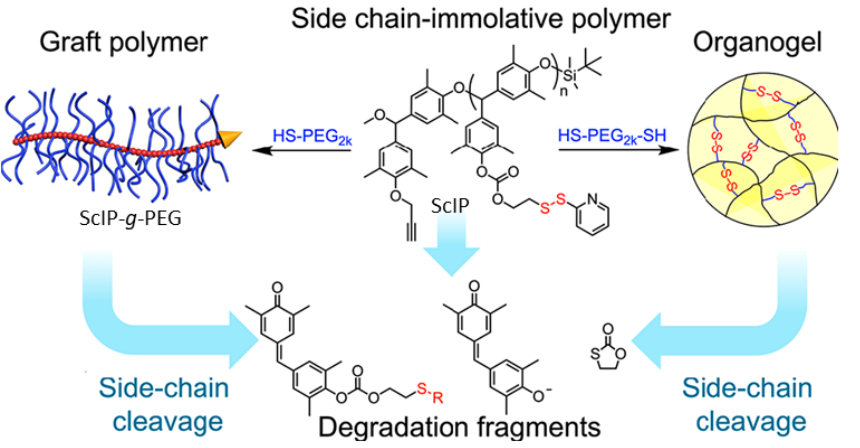
Figure 24. PBE-based ScIP structure, and reactions with mono- and bis-mercapto-terminated PEG. The graft polymer (ScIP-g-PEG), organogel, and ScIP can all be degraded by DTT. Reprinted with permission from [89]. Copyright (2019) American Chemical Society.